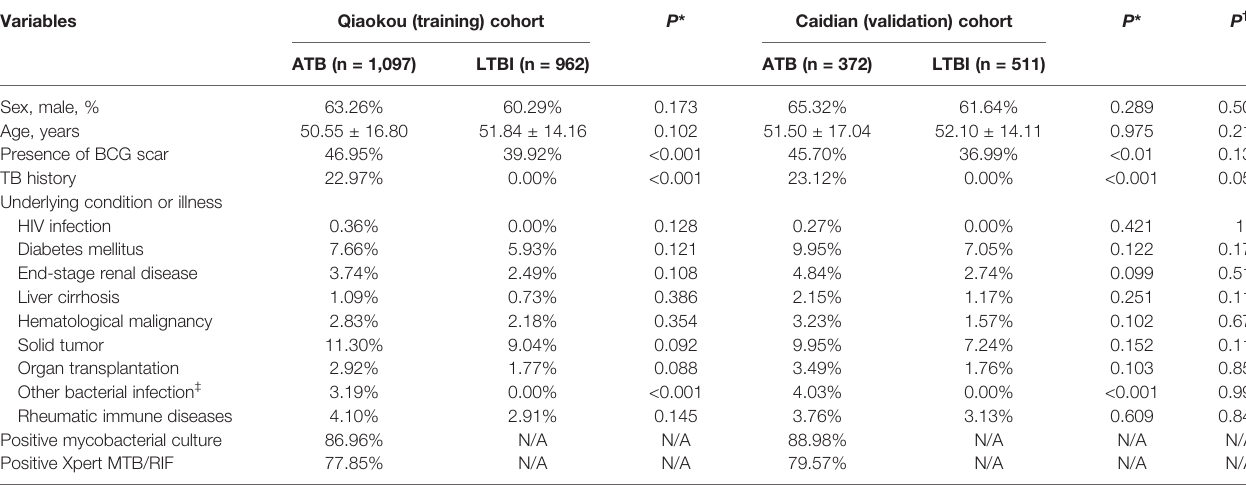
TABLE 1 | Demographic and clinical characteristics of study participants.